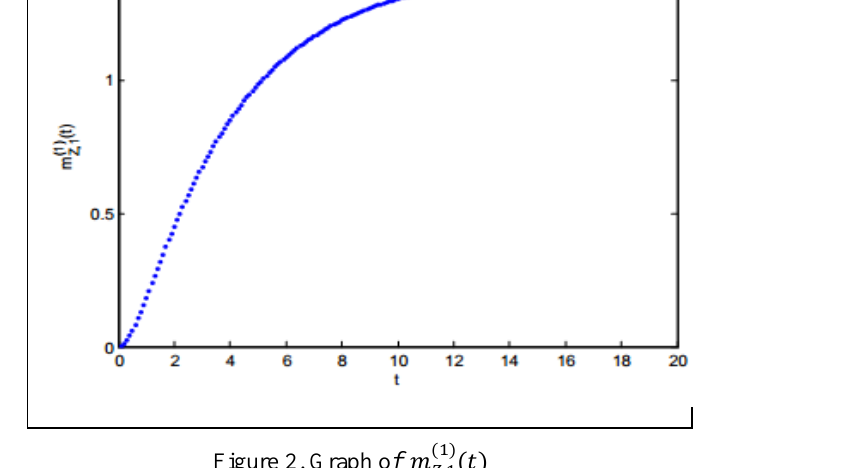
Figure 2. Graph o f 𝑚 𝑍,1(1) (𝑡)